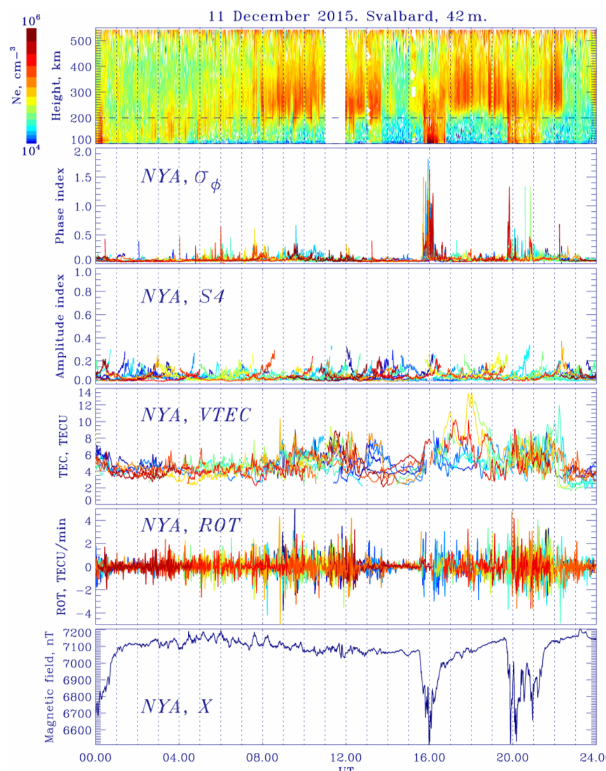
Figure 3. Ionosphere plasma density according to the EISCAT 42m radar data, phase scintillation index and amplitude scintillation in- dex according to the GPS receiver at NYA station, TEC and ROT variations according to the GPS receiver at NYA station, and geo- magnetic field variations ( X component) at NYA station for 11 De- cember 2015.